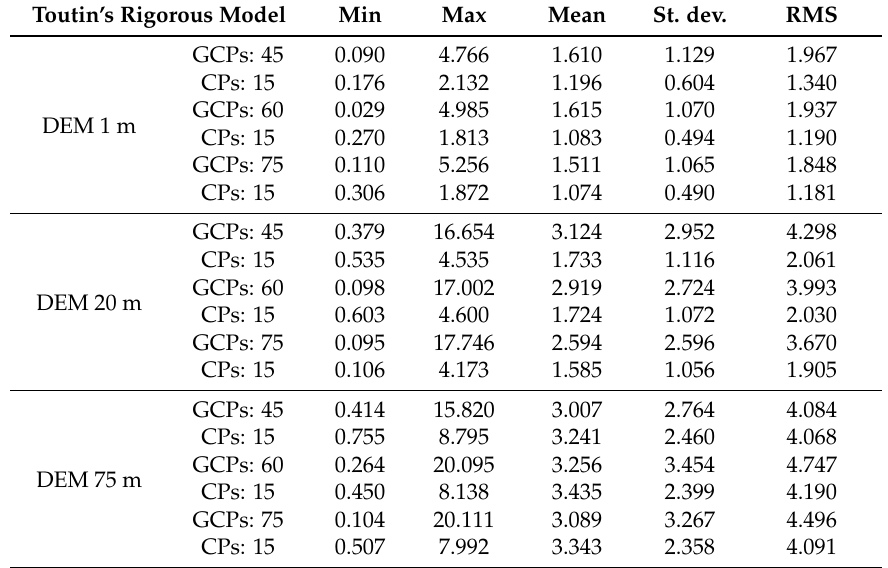
Table 7. Residuals (in meters) obtained for GCPs (45-60-75) and CPs using Toutin’s rigorous model. Toutin’s Rigorous Model Min